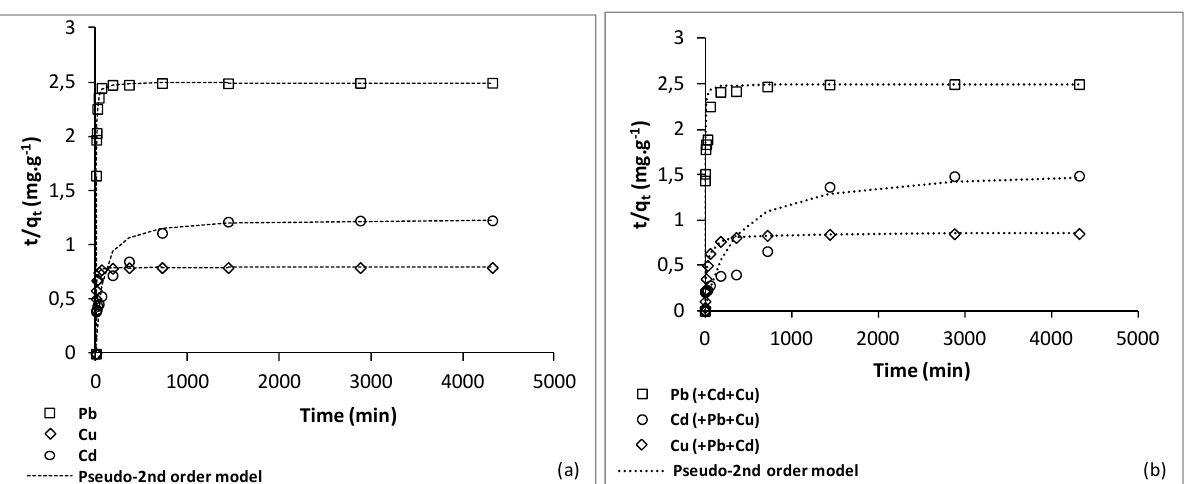
Figure 2. Pseudo-second order kinetics plots of Pb 2+ , Cu 2+ and Cd 2+ in the soil: ( a ) Monometal batch tests; ( b ) Tri-metal batch